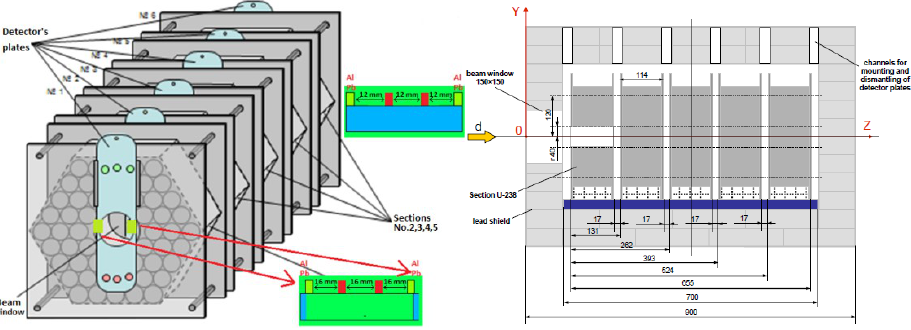
Figure 1. Experimental setup QUINTA [16] and arrangement of cobalt and lead activation detectors. The detectors were positioned on the edges of the aluminium holders. Width of the very front holder is 84 mm. Width of the other holders is 68 mm thick. Red rectangles symbolize foil placements of the CC experiment (see section 2.3). Distance between the foils on the front holder and the edge of the holder is 2 mm. Beam enters the setup through the beam window. Dimensions are given in